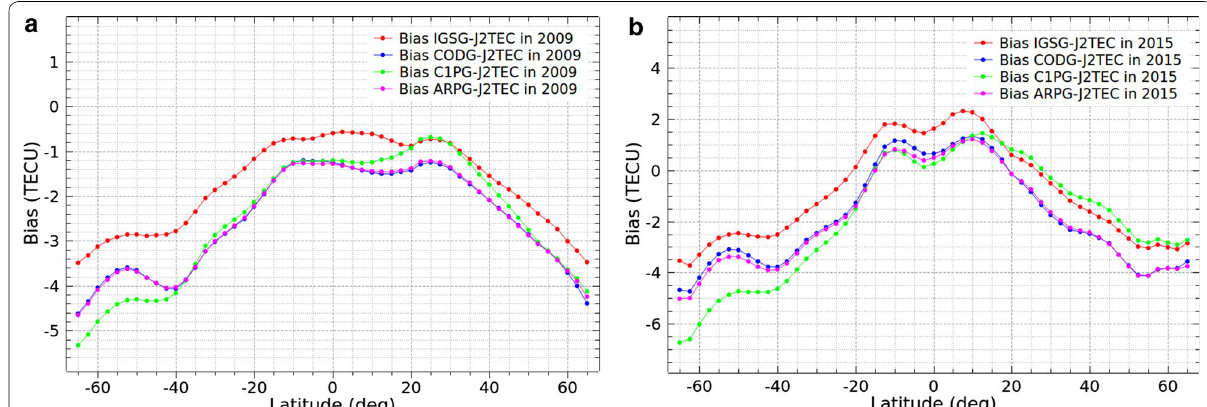
Fig. 11 Bias of the differences between forecasting VTEC maps, final GIMs, and J2TEC in 2009 and 2015. The red, blue, green, and magenta dotted lines depict the bias of the final IGS GIMs, the final CODE GIMs, the CODE forecasting VTEC maps, and forecasting products by proposed adaptive AR model, respectively, compared to VTEC values derived from JASON data. a Bias of VTEC maps minus J2TEC in 2009. b Bias of VTEC maps minus